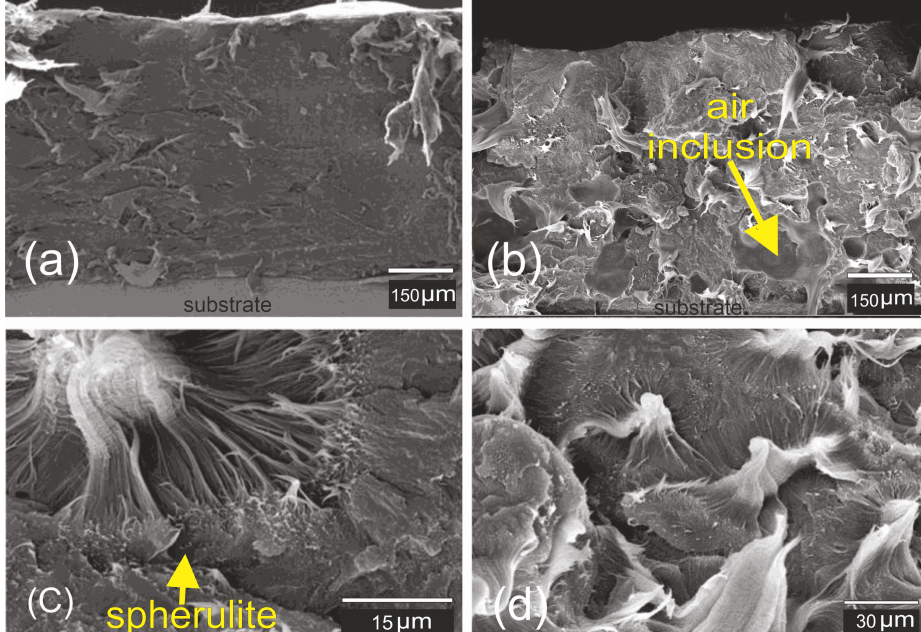
Figure 14. Macrostructures of coatings. ( a , c ) Characteristic structure formed according to mode-2. ( b , d ) Characteristic structure formed according to mode-1.